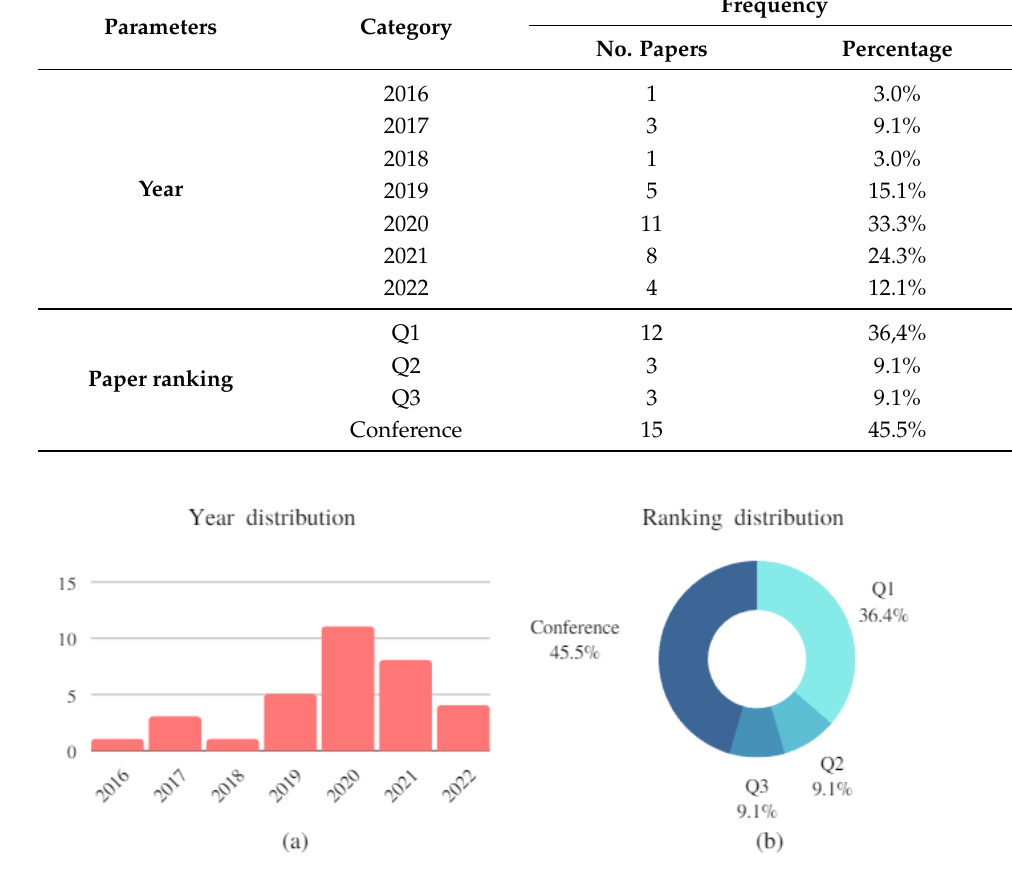
Figure 4. ( a ) Represent the frequency by year and ( b ) the distribution by conference and paper